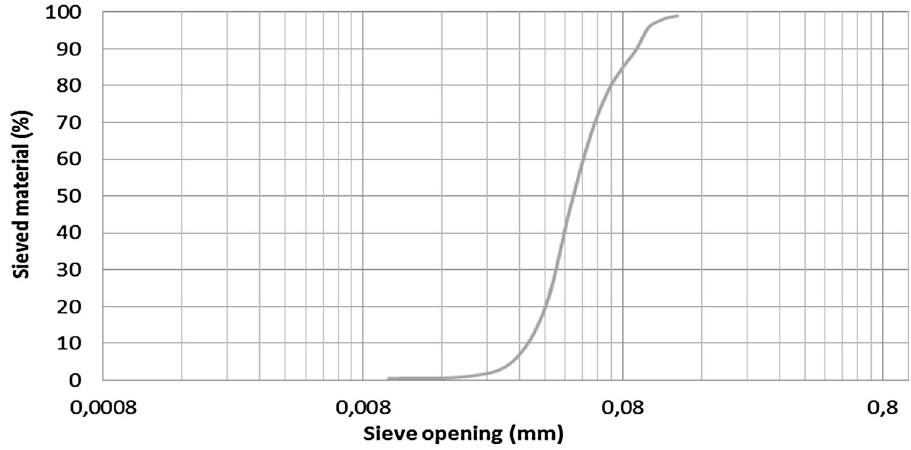
Fig. 5 Granulometric (grain-size) curve of